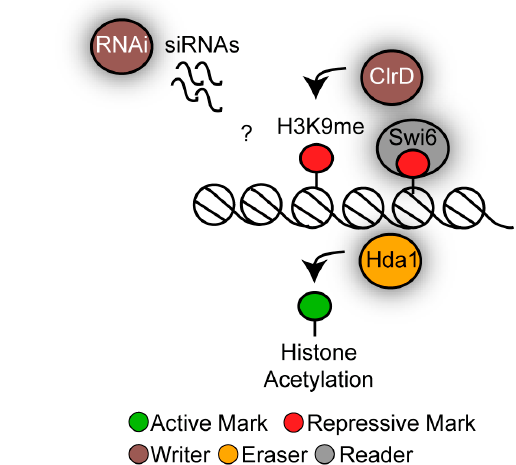
Figure 7. Heterochromatin structure in Aspergillus fumigatus . The methyltransferase Clr4. methylates H3K9 creating a binding site for the chromodomain reader proteins Swi6. The histone deacetylase Hda1 maintains the hypoacetylated histone state. It is unknown whether the RNAi machinery contributes to heterochromatin assembly.